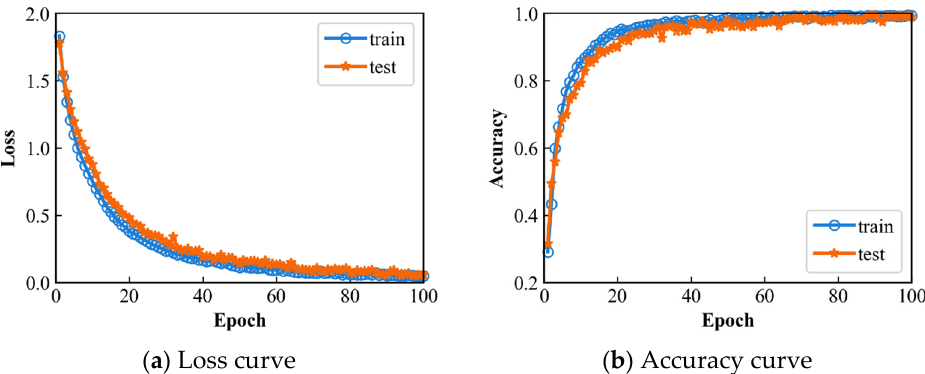
Figure 9. Loss curve and accuracy curve of federated fault diagnosis model.